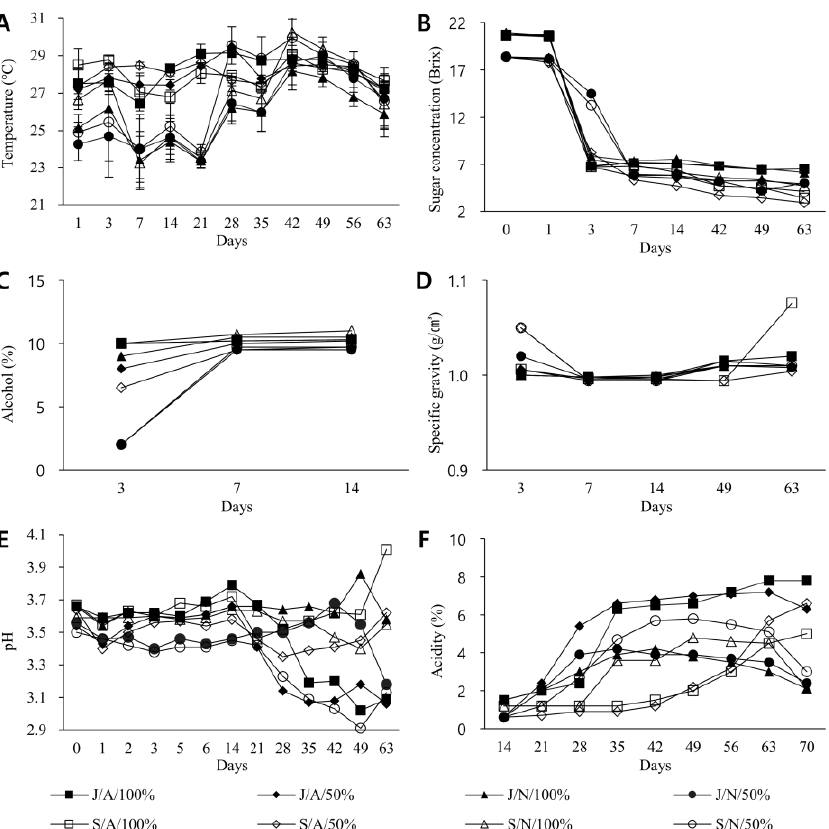
Figure 1. Analysis of basic physiochemical properties of vinegar by fermentation conditions and duration. During fermentation under eight different fermentation conditions, vinegar was sampled and ( A ) temperature, ( B ) sugar concentration, ( C ) alcohol concentration, ( D ) specific gravity, ( E ) pH, and ( F ) total acidity were measured. Names of the eight different fermentation conditions were: J/A/100%, J/A/50%, J/N/100%, J/N/50%, S/A/100%, S/A/50%, S/N/100%, and S/N/50% (J = fermentation in jars; S = fermentation = fermentation in stainless steel vessels). A and N represent fermentation with temperature/oxygen adjusted and natural fermentation outdoors, respectively; 100% and 50% indicate that bokbunja stock was used for fermentation, and bokbunja liquid diluted 50% with purified water was used for fermentation.